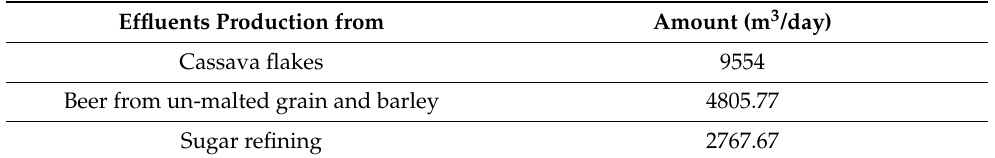
Table 1. Estimates of effluents from the process in the production of cassava flakes, beer, and sugar in southwestern